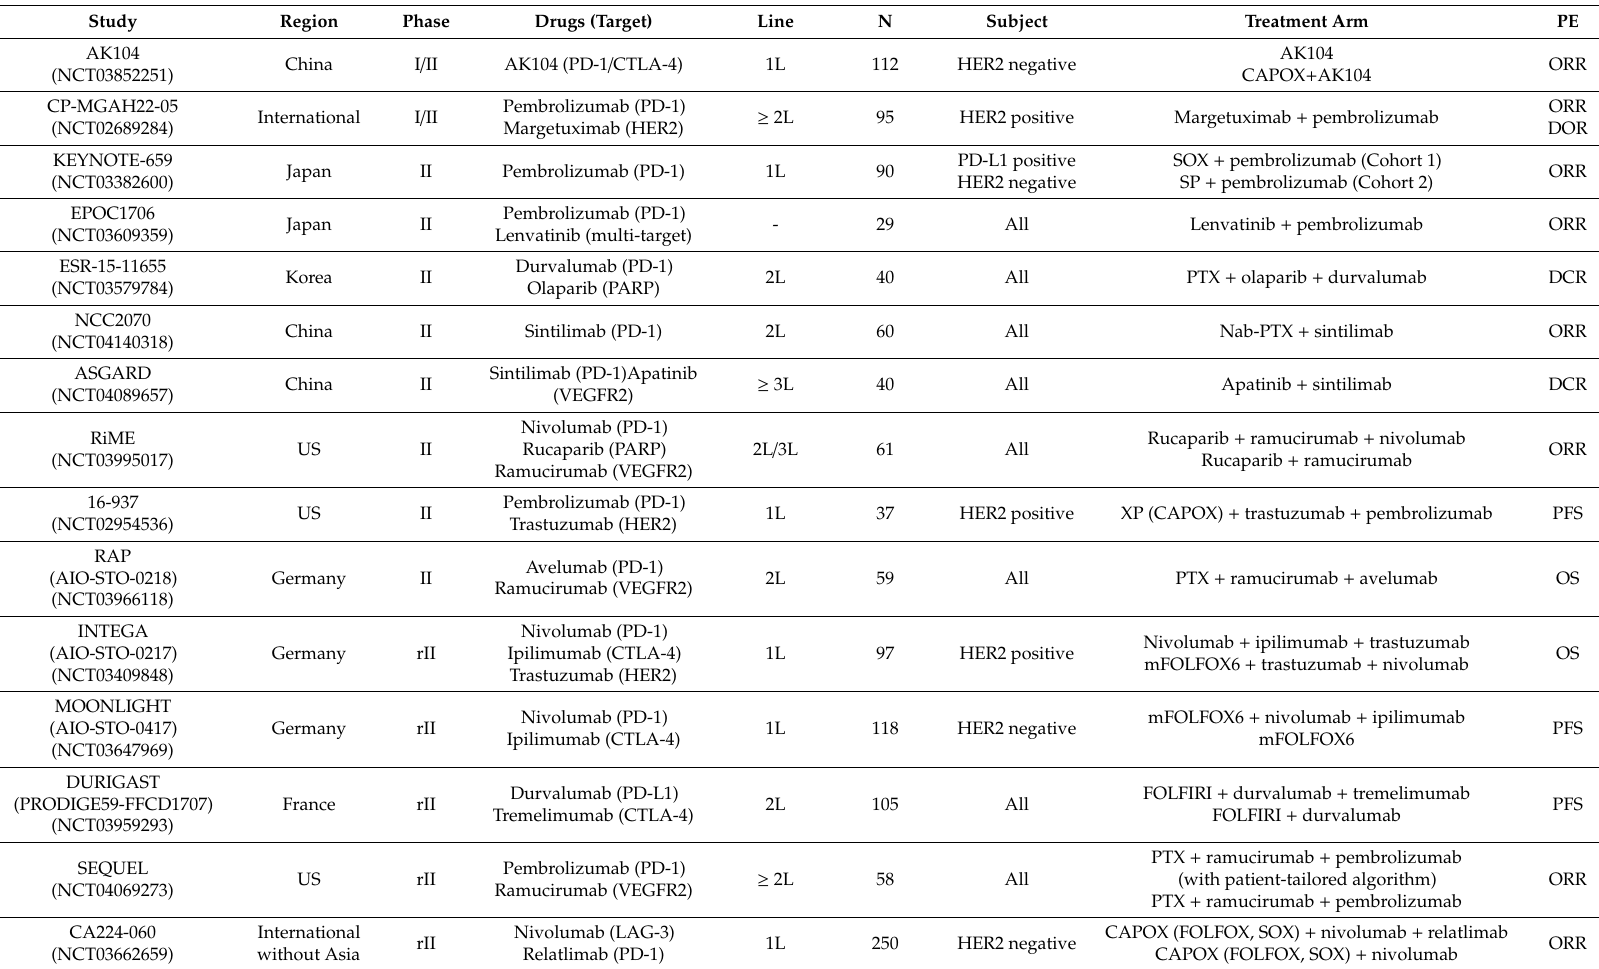
Table 4. Ongoing clinical trials of immune checkpoint inhibitors in advanced gastric